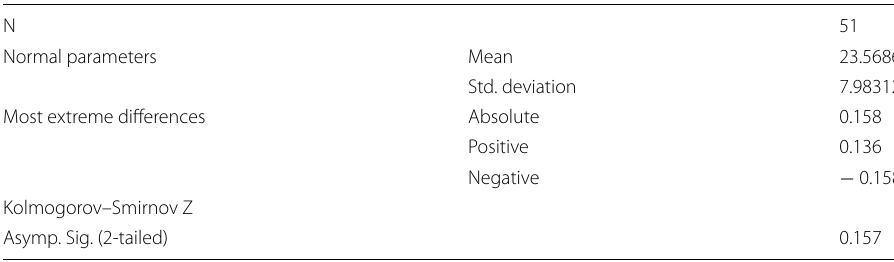
Table 2 Kolmogorov–Smirnov test (control group) N Normal parameters